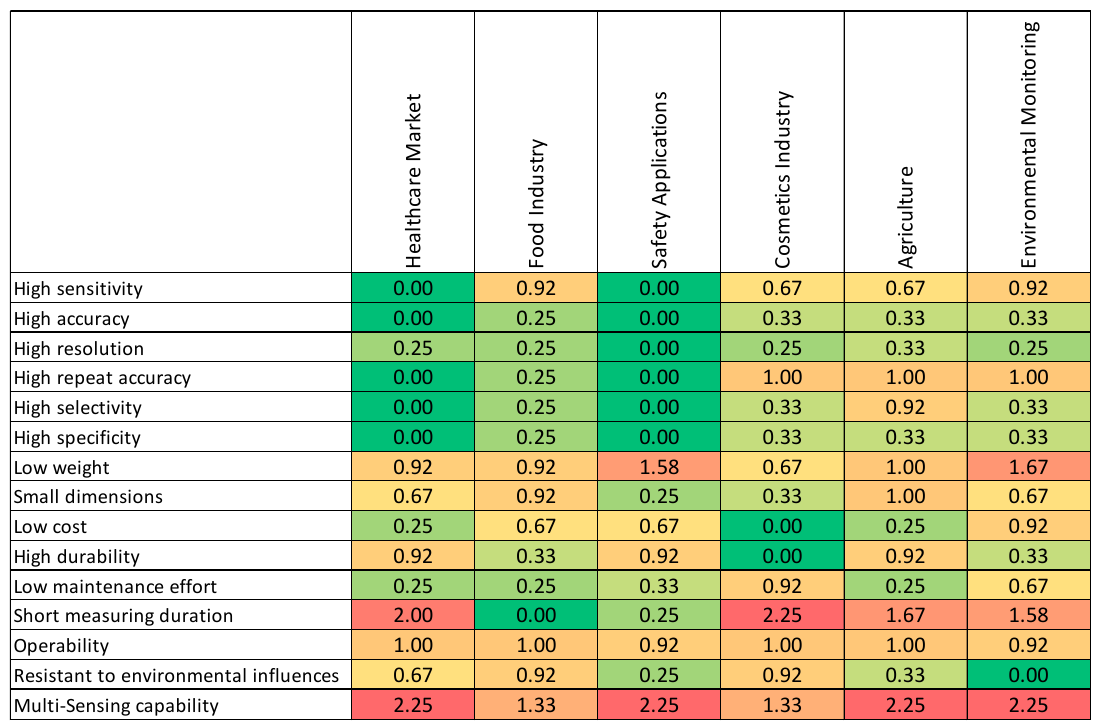
Figure 4. Statistical variances of the survey results shown in Figure 3 (red = higher values, green = lower